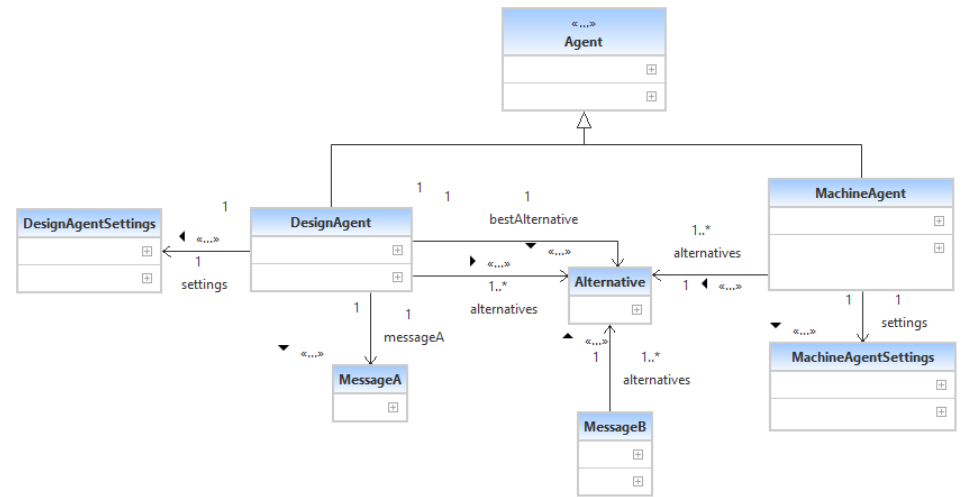
Figure 6. UML Class diagram of main platform components.